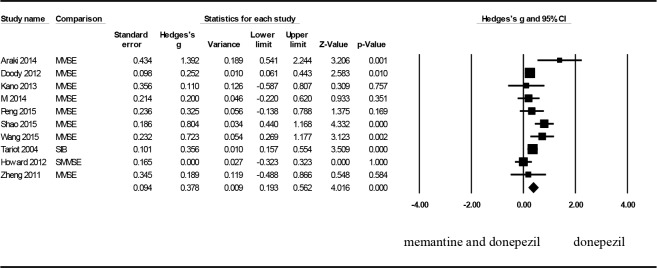
Forest plots to compare the combination therapy with the monotherapy: Cognitive functions.